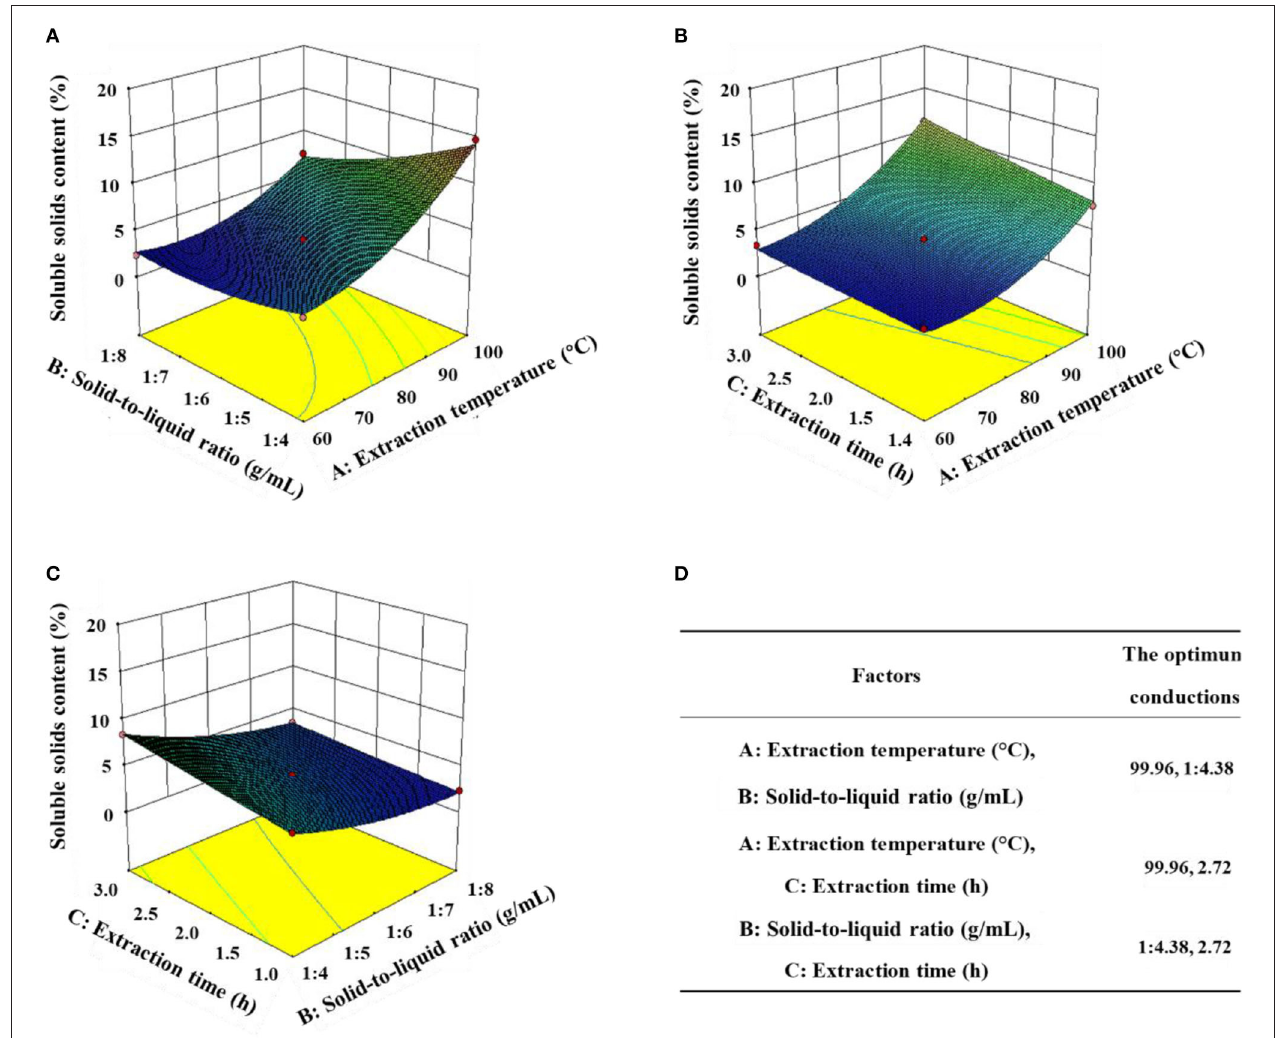
FIGURE 2 | Three-dimensional response surface methodology to evaluate the effects of the (A) solid-to-liquid ratio/extraction temperature, (B) extraction time/extraction temperature, and (C) extraction time/solid-to-liquid ratio on the soluble solid content of black garlic extract. (D) The optimal extraction conditions determined by the response surface methodology. Data are means ± SD ( n = 3).